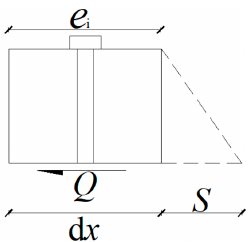
Figure 5. The interface constitutive relationship of timber–steel interface.